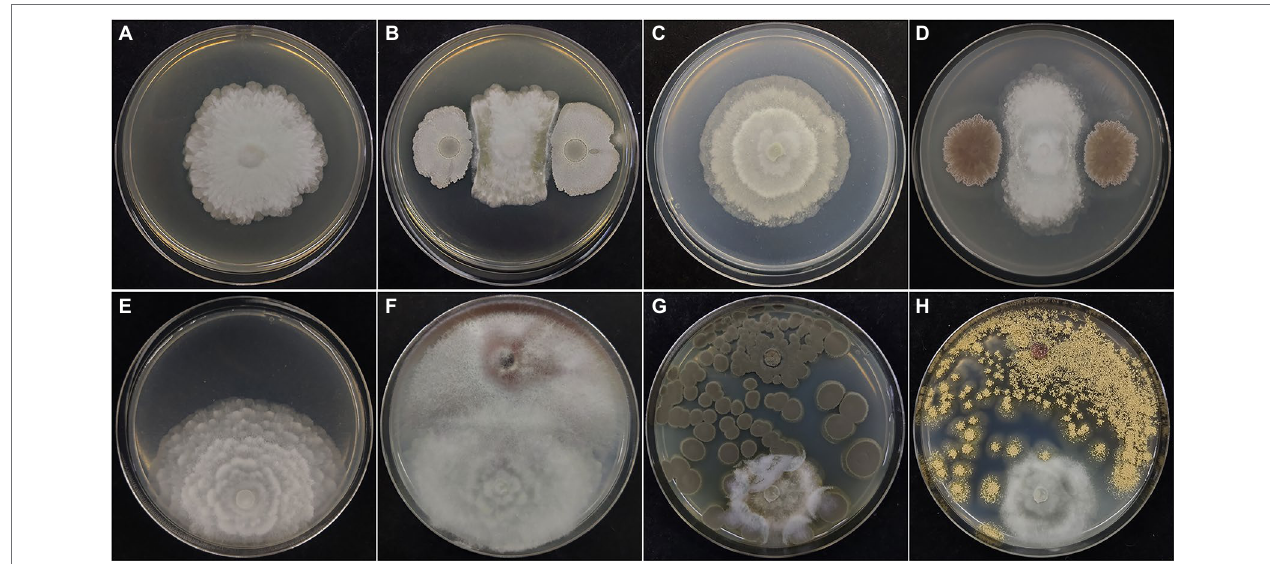
FIGURE 2 | Results of confrontation between Mortierella alpina YW25 and rhizosphere microorganisms. As the control, Mortierella alpina YW25 was inoculated separately on LB (A) , Gao’s No.1 (C) medium for 5 days, and on PDA medium 7 days (E) . Mortierella alpina YW25 was co-cultured with Bacillus velezensis (B) on LB medium, Streptomyces tricolor (D) on Gao’s No.1 medium at 28 ° C for 5 days, and with Fusarium oxysporum YFW32 (F) , Penicillium citrinum (G) , Aspergillus ochraceus (H) on PDA medium at 28 ° C for 7